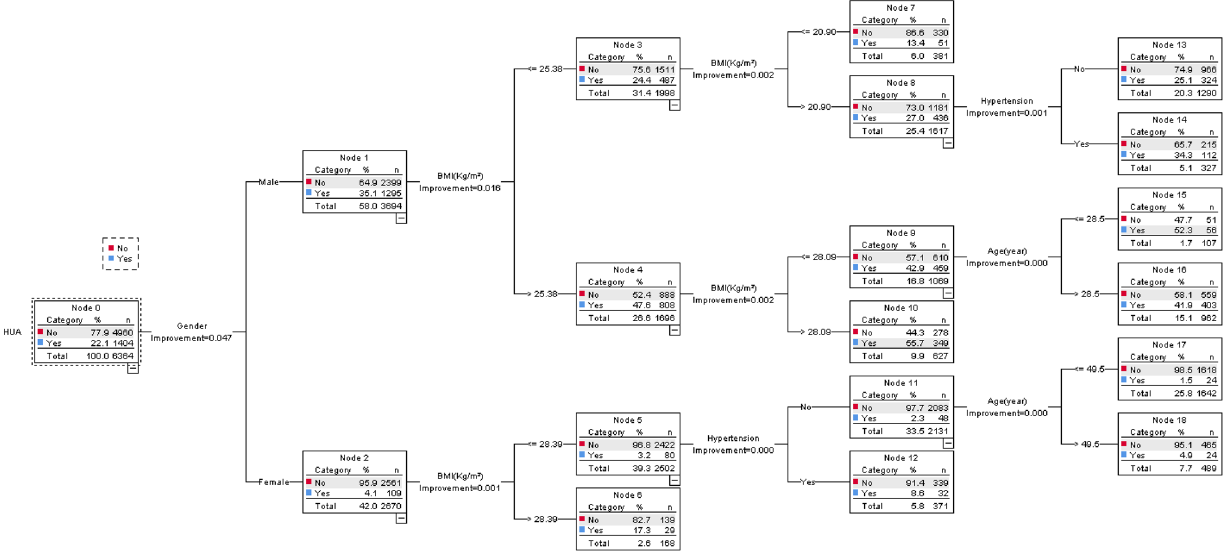
Figure 2. The classification tree model of HUA patients. The figure was created by using SPSS 25.0 (IBM, USA), URL: https:// www. ibm. com/ produ cts/ spss- stati stics/. HUA: hyperuricemia; BMI: body mass index.